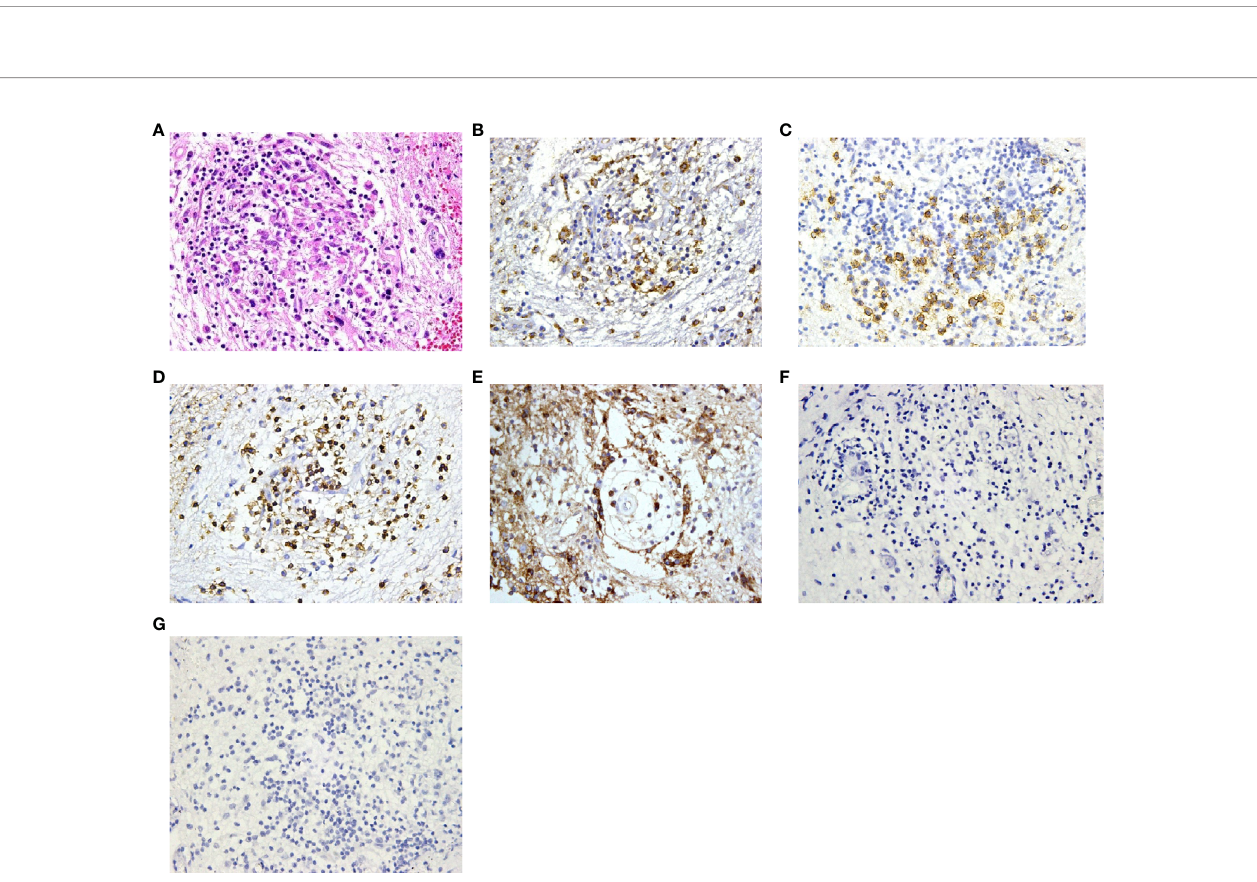
FIGURE 5 | Histopathology and immunohistochemistry manifestations of hypothalamitis in patient No. 17. (A) Notable proliferation of lymphocyte, plasma cells and histiocyte was found in H&E staining (H&E, ×200 original magni fi cation); Immunohistochemical analysis revealed scattered CD68 (B) , CD138 (C) and CD3 (D) cells, with IgG deposition (E) . CD20 (F) and CD1a (G) cells were